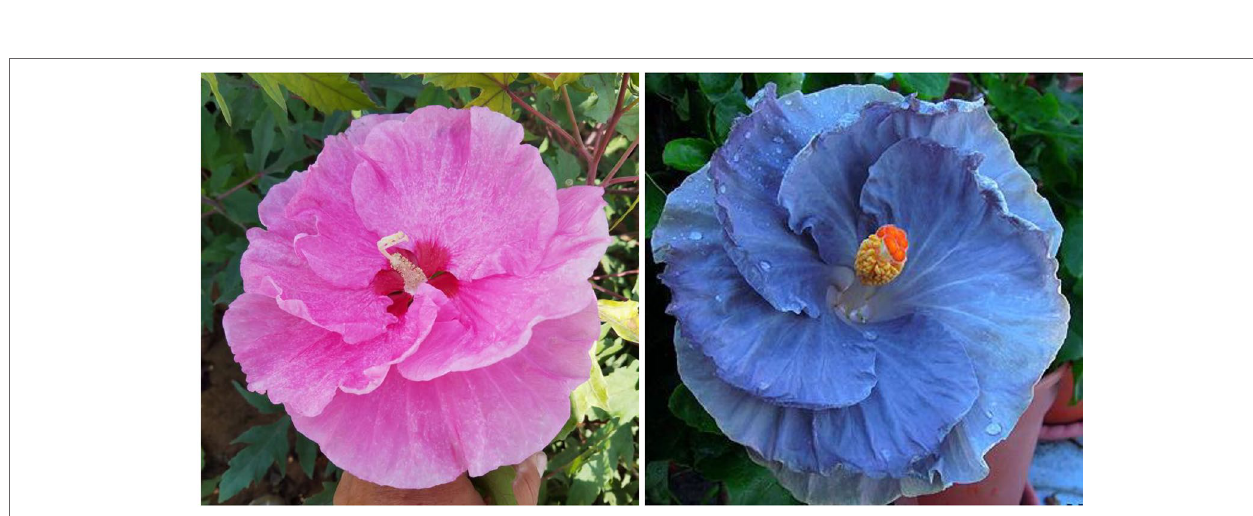
FIGURe 13 | Flower shape of H. x moscheutos hybrid “TAMUS-5050” (left) and H. rosa-sinensis “Moorea Abyss” (right). Photo credits: Dariusz P. Malinowski (“TAMUS-5050”) and Linda Lee (“Moorea Abyss”),